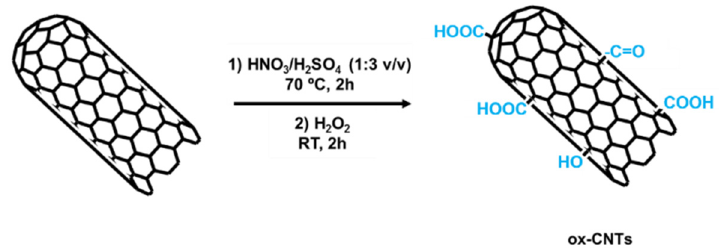
Figure 1. Schematic representation of the chemical oxidation of carbon nanotubes (CNTs).